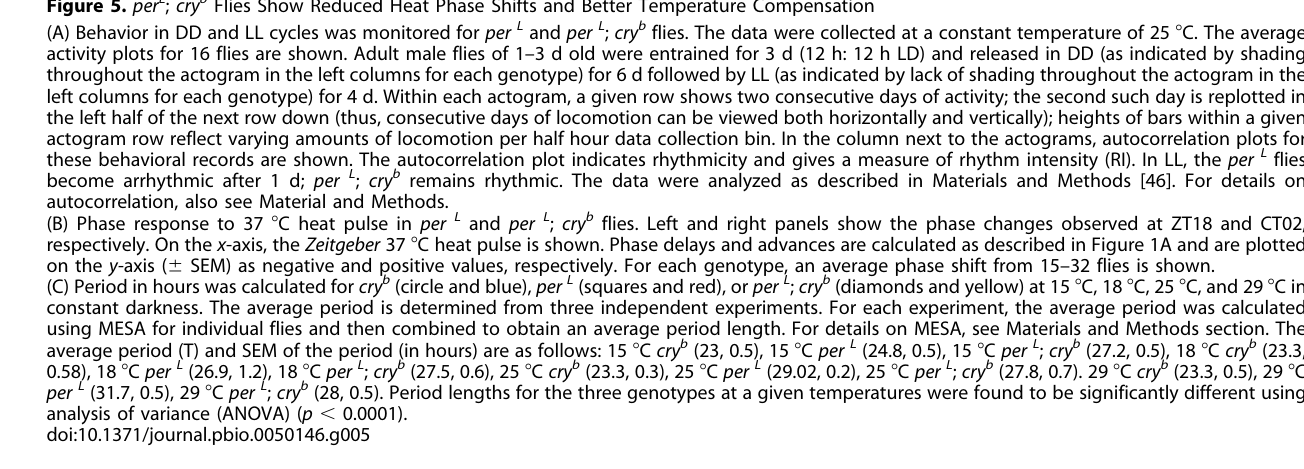
flies. This indicates that a temperature-sensitive CRY:PERL- ature compensation. It also connects the free-running period response to a heat pulse. Indeed, there is also a CRY:PERL-